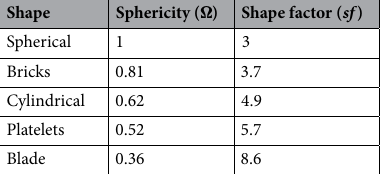
Table 2. Nanoparticles’ shape and sphericity 47,48 .